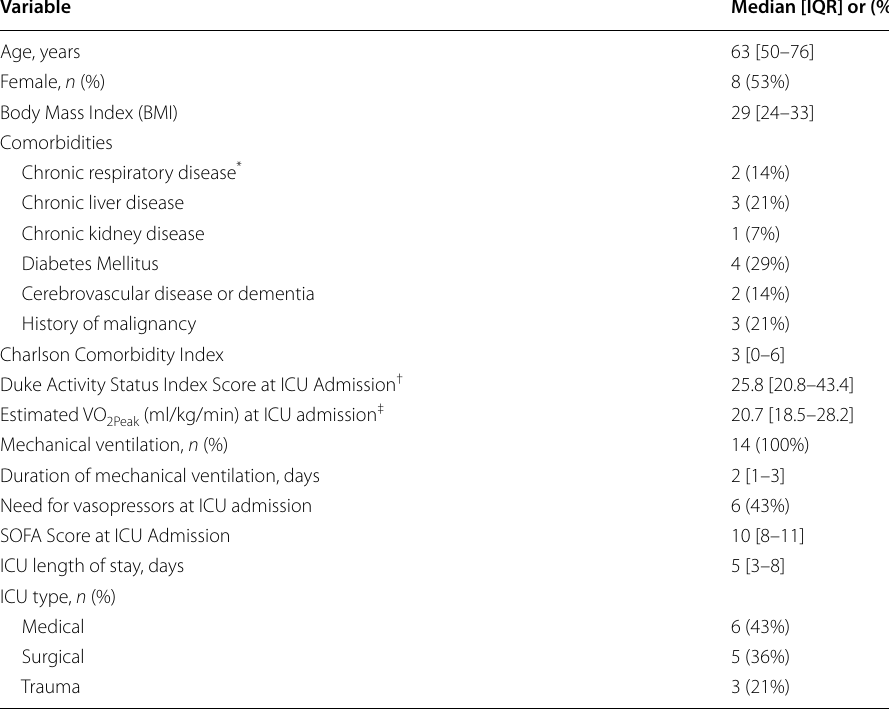
Table 1 Cohort characteristics ( N